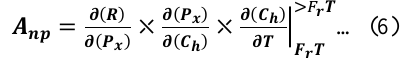
The respective temperatures in the thermal imager for